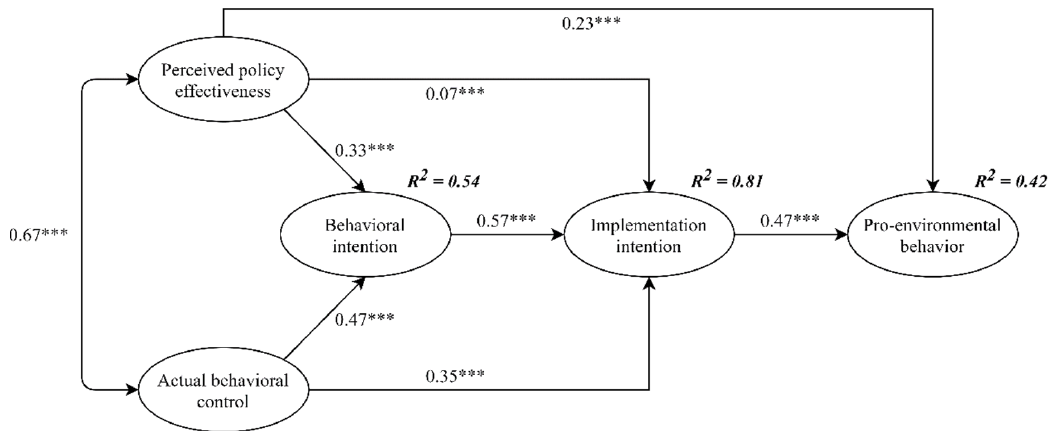
Figure 3. Structural equation modeling of the hypothesized model. * p < 0.05, ** p < 0.01, *** p < 0.001; Standardized coefficients are reported.